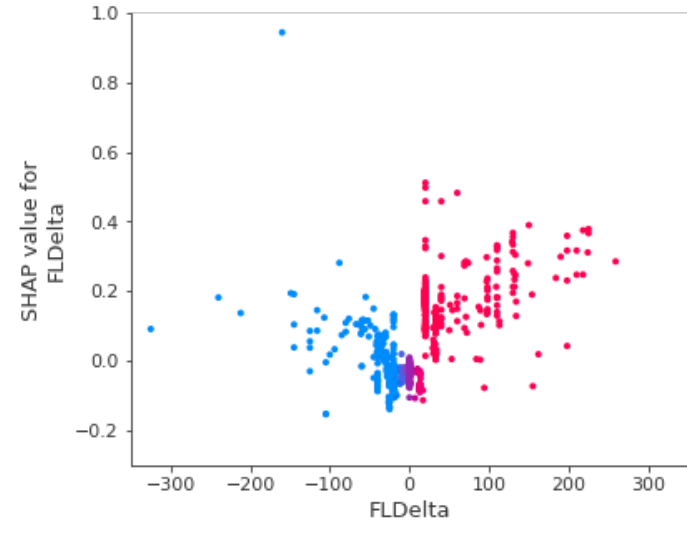
Figure 9. SHAP values (regression) of FLDelta for Sector